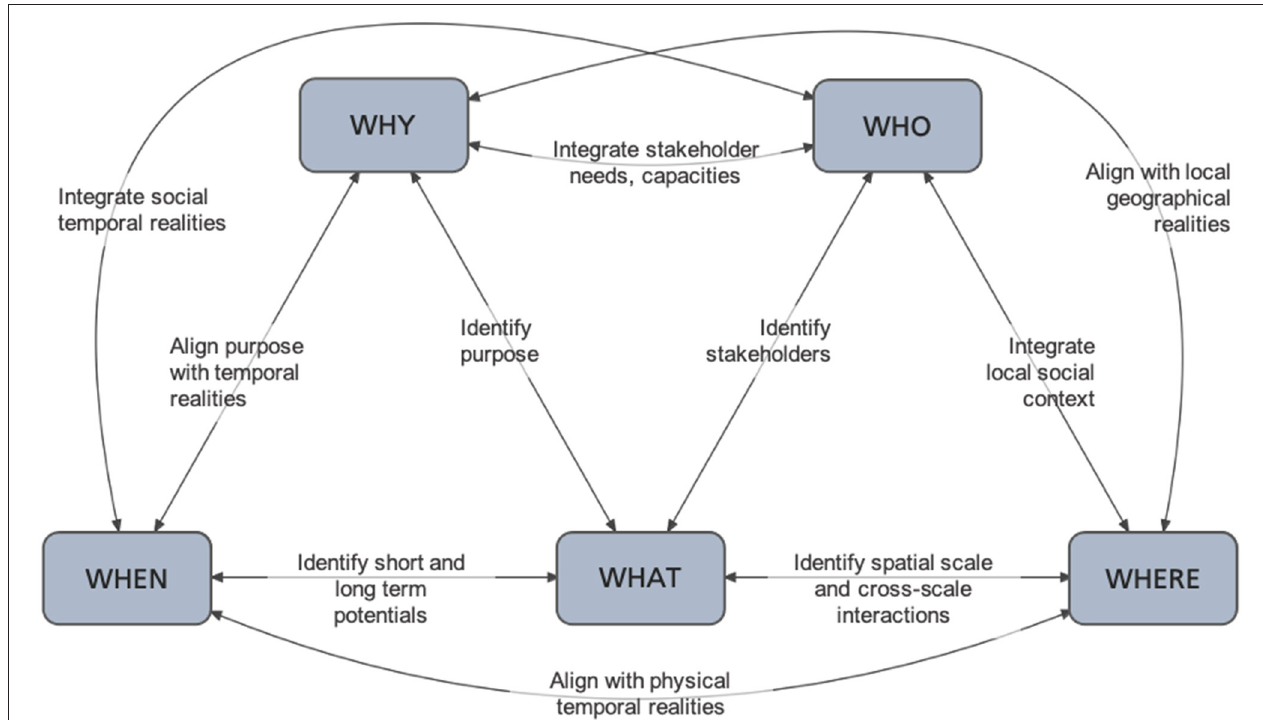
FIGURE 2 | Broad connections between the five Ws of nexus research. While “identify” and “align” are more self-explanatory for the diagram, “integrate” here indicates a process of inclusion of other relevant perspectives/knowledge from academic and non-academic